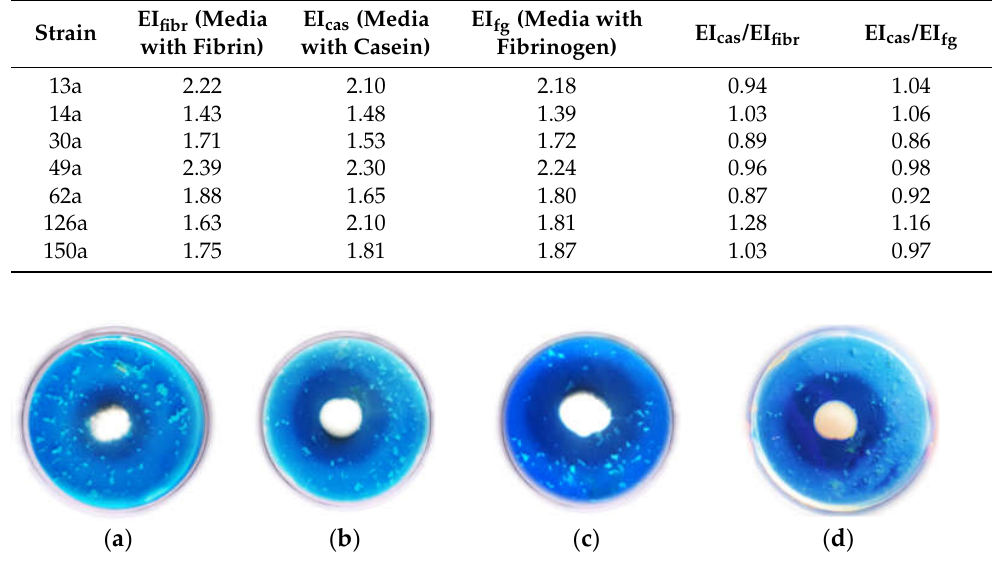
Figure 3. Example of enzymatic index determination in a medium with fibrin for T. inflatum ( a ) 49a, ( b ) 126a, ( c ) 13a, and ( d ) 62a strains.